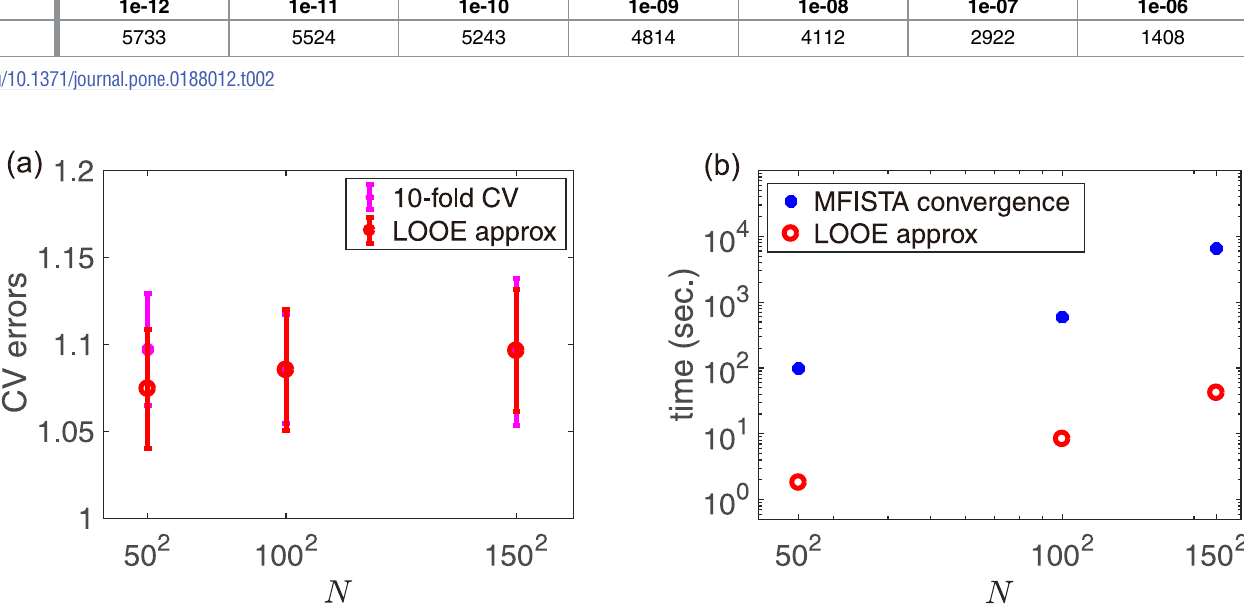
Fig 4. (a) Plot of mean CVEs at optimalparameters of different sizes. (b) Log-logplot of the computational times for solvingthe optimization problem (3) and for obtainingthe approximate value of CVE againstthe size of datasets.